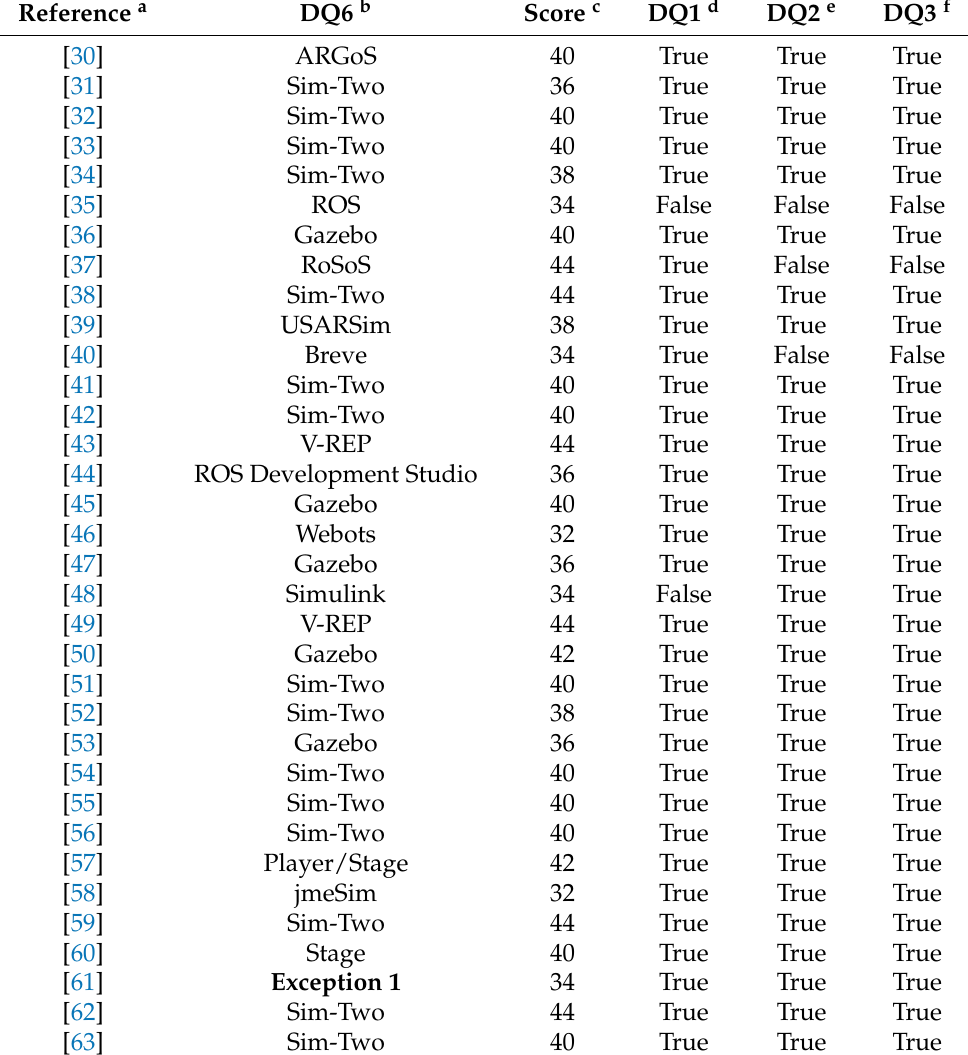
Table 3. All the papers included in the SLR. In ( a ) All the selected studies about simulators. ( b ) The answer for Data Question 6 ( DQ6 ), in which the answer is the name of the simulator used in the refereed study. The ( c ) column is the paper’s score in the quality assessment. Lastly, ( d ), ( e ) and ( f ) columns concern the ability to simulate robotics, sensors and actuators, addressing Data Questions ( DQ1 ),( DQ2 ) and ( DQ3 ),